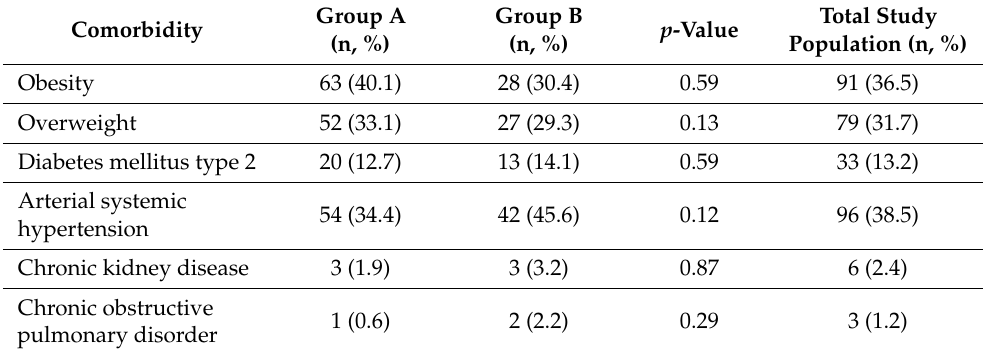
Table 1. Comorbidities in COVID-19 patients with and without liver